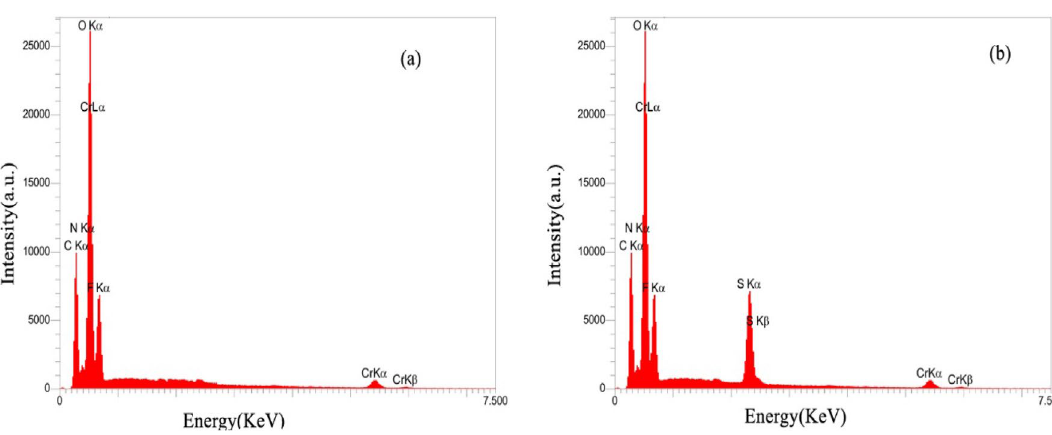
Figure 3. The EDX spectra of ( a ) MIL-101(Cr) MOF and ( b )